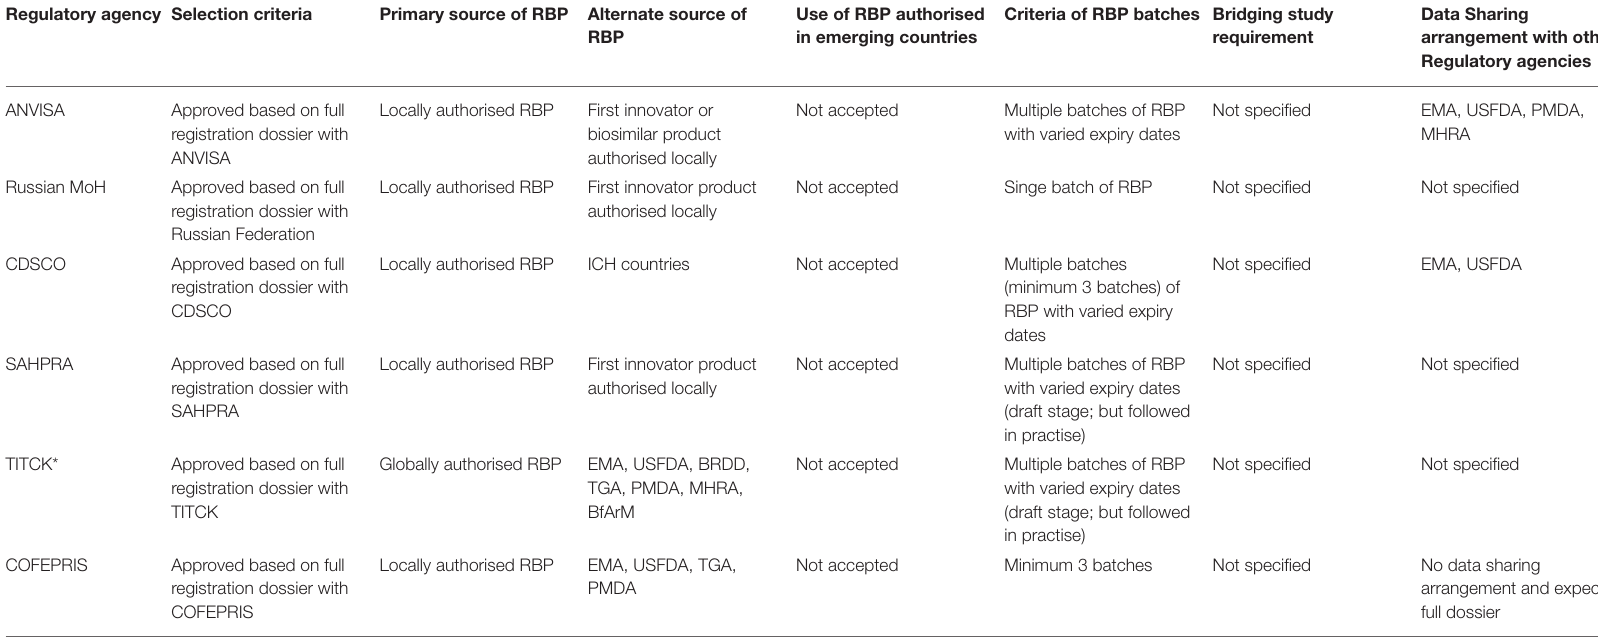
TABLE 3 | RBP selection criteria for six regulatory agencies of